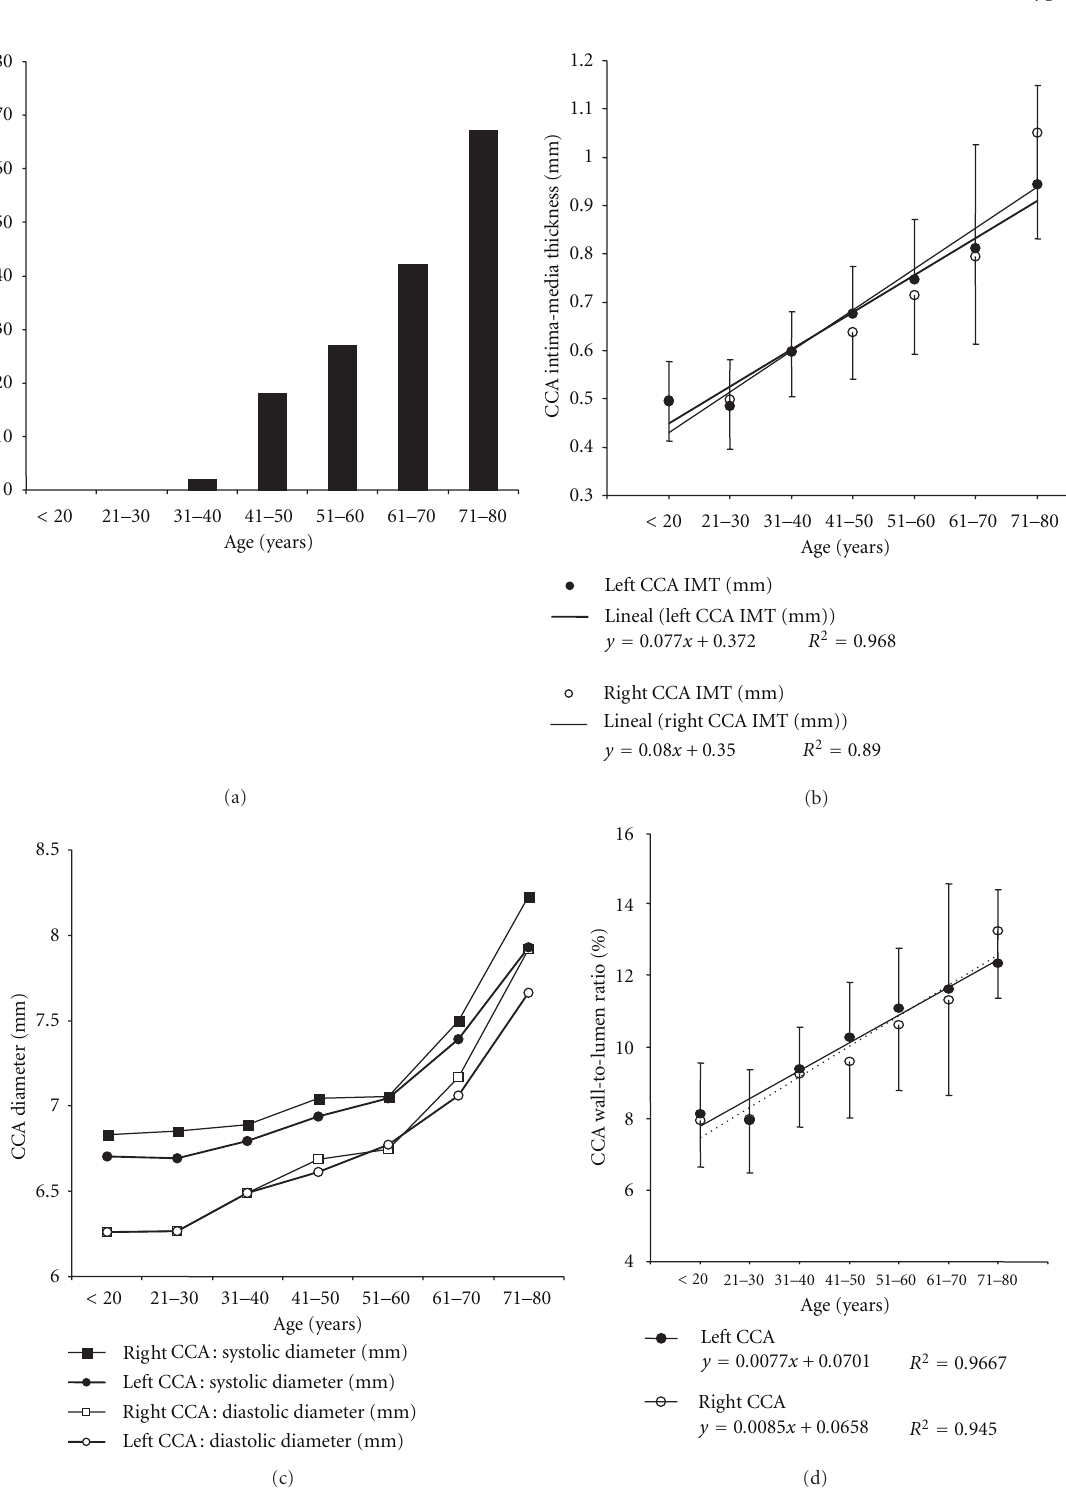
Figure 4: Carotid atherosclerotic plaque prevalence (a) and common carotid artery (CCA) intima-media thickness (b), diameters (c), and wall-to-lumen ratio (d) age- (decade-) related